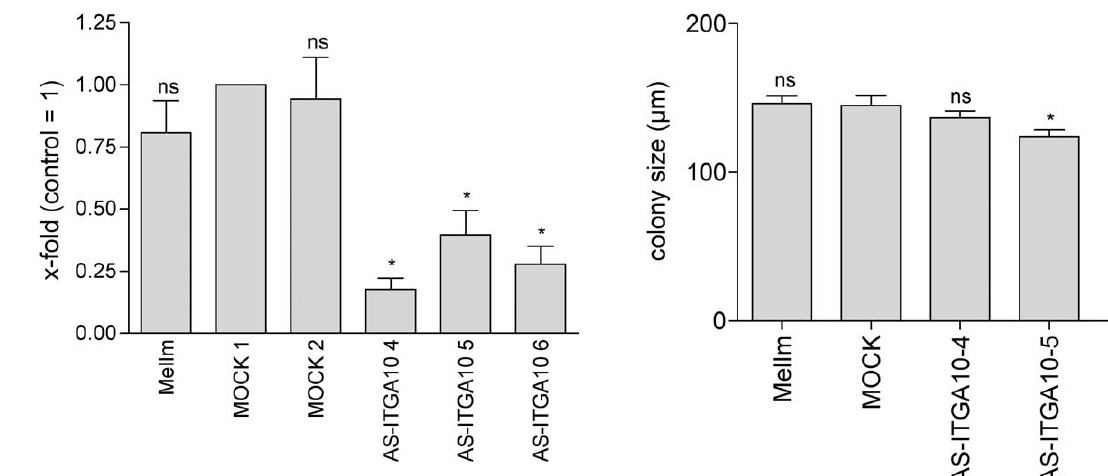
Fig. 5. Effect of reduction of integrin alpha10 on anchor- age-independent growth. Changes in anchorage-independent growth of the cell clones expressing less integrin alpha10 were analyzed in comparison to non transfected Mel Im cells and the mock transfected clone 2. Only marginal changes were found after downregulation of expression of integrin alpha10 (*: p < 0 . 05, ns: not